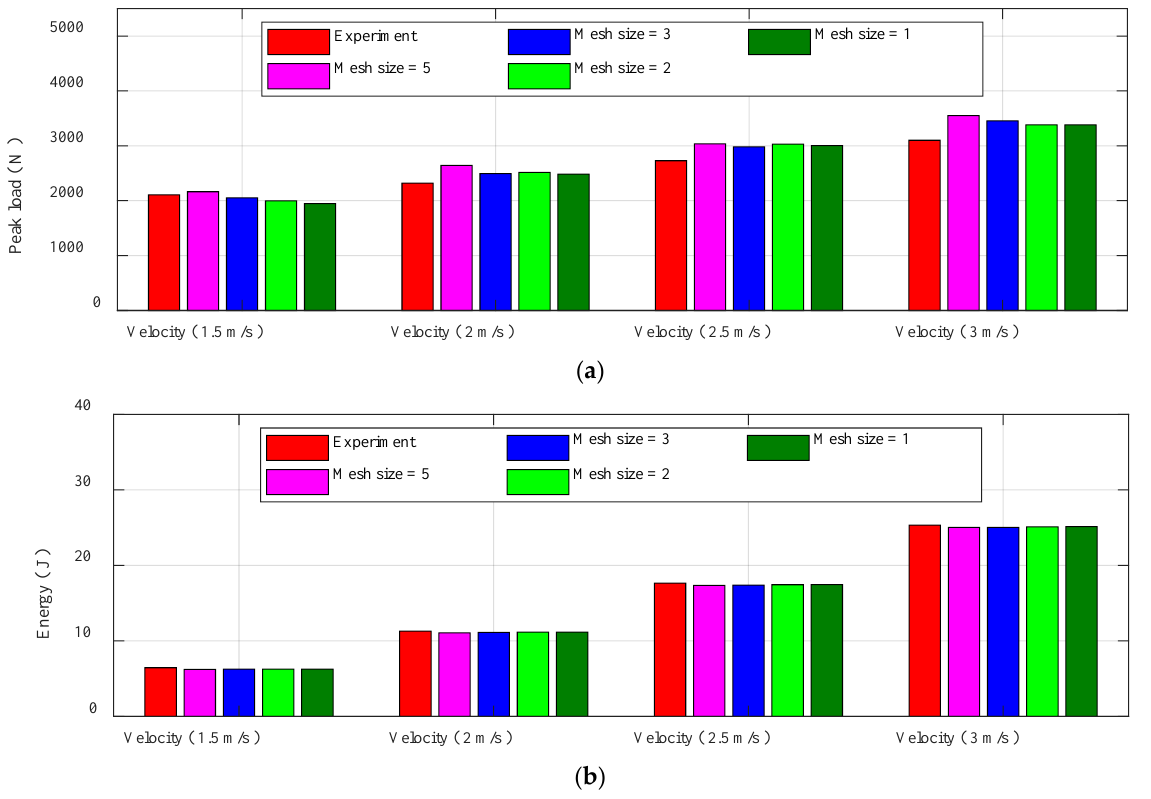
Figure 5. Different numerical outputs for different impact velocities and mesh size: ( a ) Peak load (N) and ( b ) energy (J).